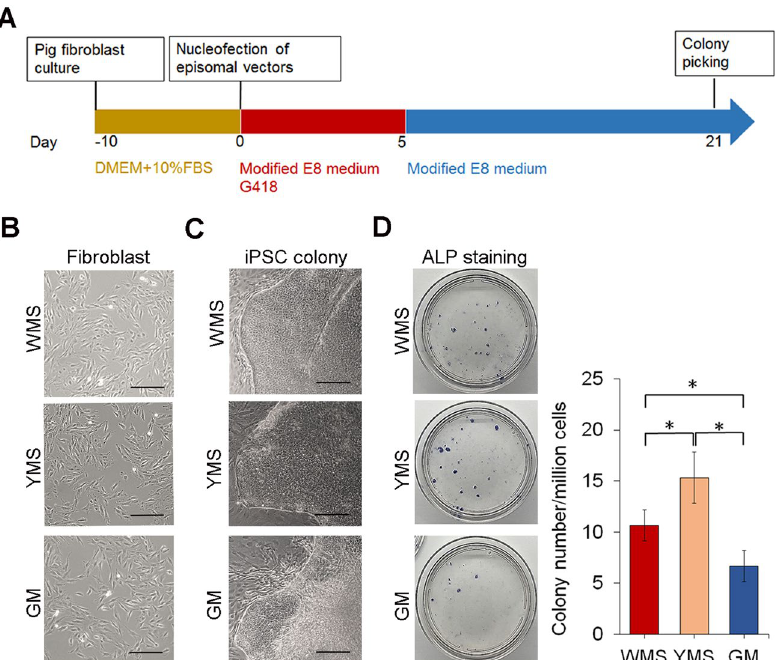
Figure 1. Generation of iPSCs from fibroblasts of three breeds of miniature pigs. ( A ) Schematic diagram illustrating the timeline and stepwise procedures to establish iPSC lines. ( B ) Phase-contrast images showing flat, elongated cells with typical fibroblast morphology. ( C ) Phase-contrast images showing pig iPSC colonies with well-defined borders at day 21 post transfection. ( D ) ALP staining of iPSC colonies and corresponding reprogramming efficiency presented by the number of ALP-positive colonies per million cells. ALP-positive colonies in each 100-mm dish were counted. Scale bar = 200 µm. * p < 0.05; n =